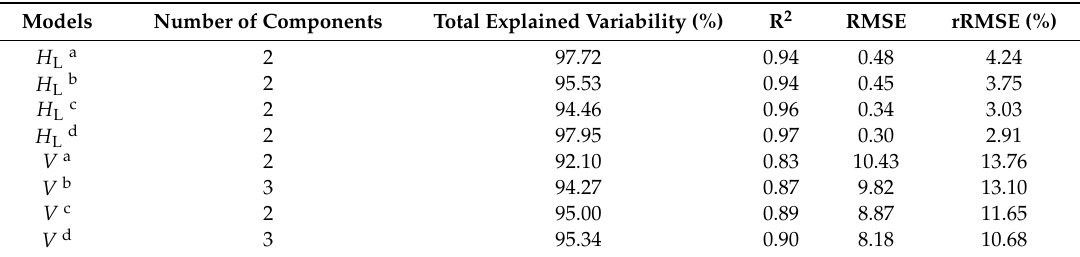
Table 7. Summary of the forest structural attributes prediction models with spectral metrics derived from the UAS multispectral imagery and structural metrics derived from the UAS RGB DAP point cloud. The best models based on the standard error of the cross-validation residuals are displayed with the number of components, total explained variability (%), cross-validated coefficient of determination (R 2 ), cross-validated Root-Mean-squared-Error (RMSE), and relative RMSE (rRMSE).